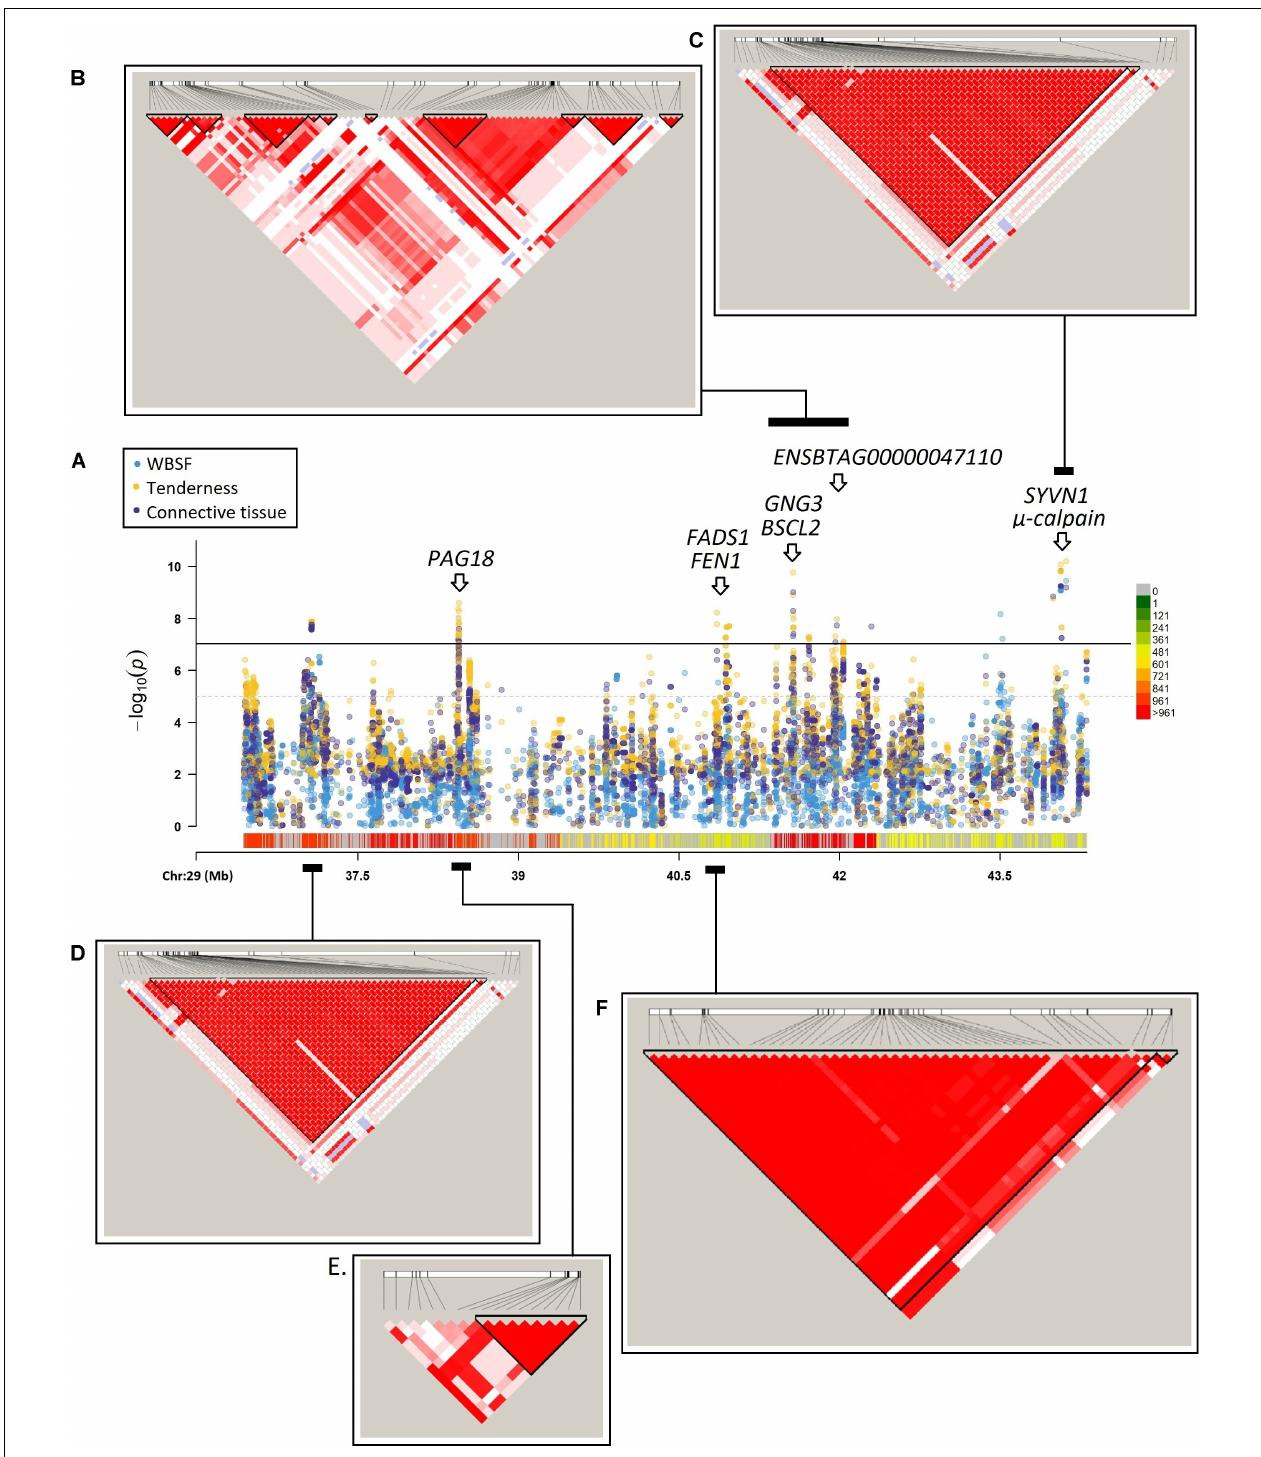
FIGURE 3 | (A) Detailed region between the markers on BTA29 located at 36,432,655 and 44,313,046 bp and its association with WBSF, tenderness, and connective tissue. This region harbors 6,100 polymorphisms. The significance threshold used was 1 × 10 - 7 . The white arrows show genes with highly significant genic markers. LD-plots for highly significant subregions comprising: (B) GNG3 , BSCL2 , and ENSBTAG00000047110 genes; (C) SYVN1 and µ -calpain genes; (D) between the base-pair positions 37,062,087 and 37,077,105; (E) PAG18 gene, and (F) FADS1 and FEN1 genes.